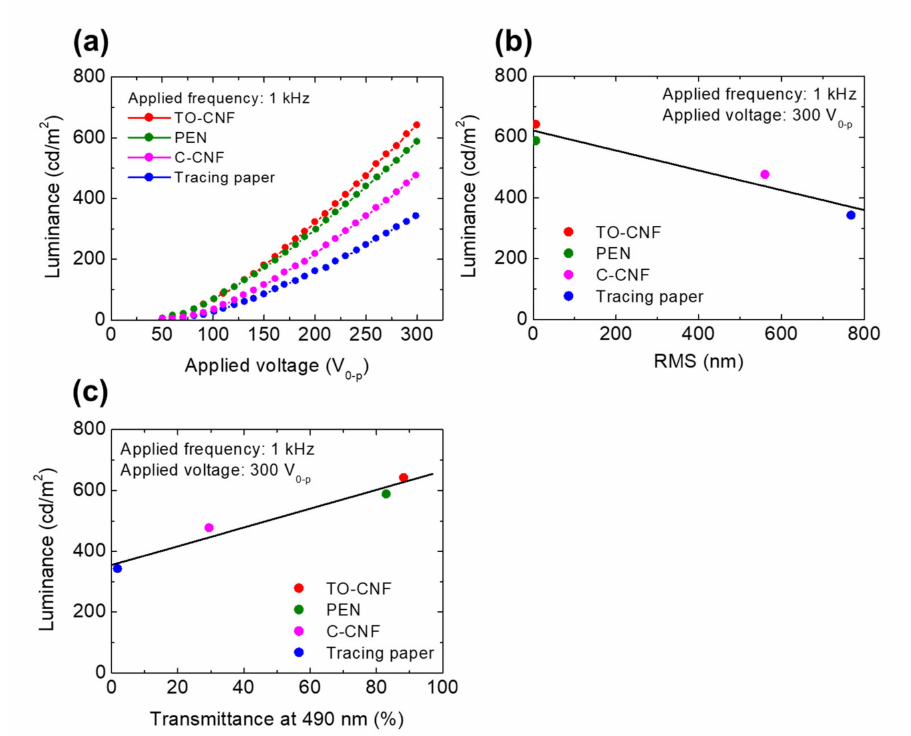
Figure 5. ( a ) The luminance of the EL devices versus the applied voltage characteristics at an applied frequency of 1 kHz. The luminance of the EL devices at an applied voltage of 300 V 0–p at 1 kHz versus ( b ) RMS roughness and ( c ) transmittance of each substrate at a wavelength of 490